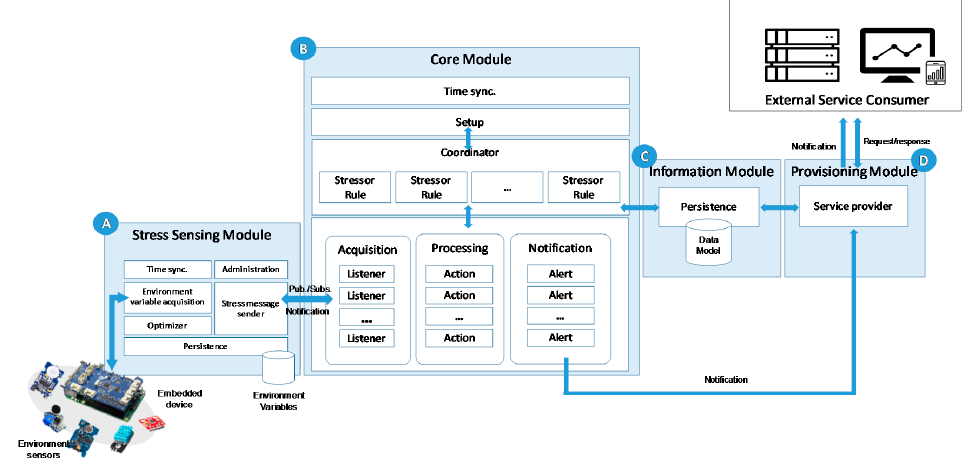
Figure 2. Architecture of the system.